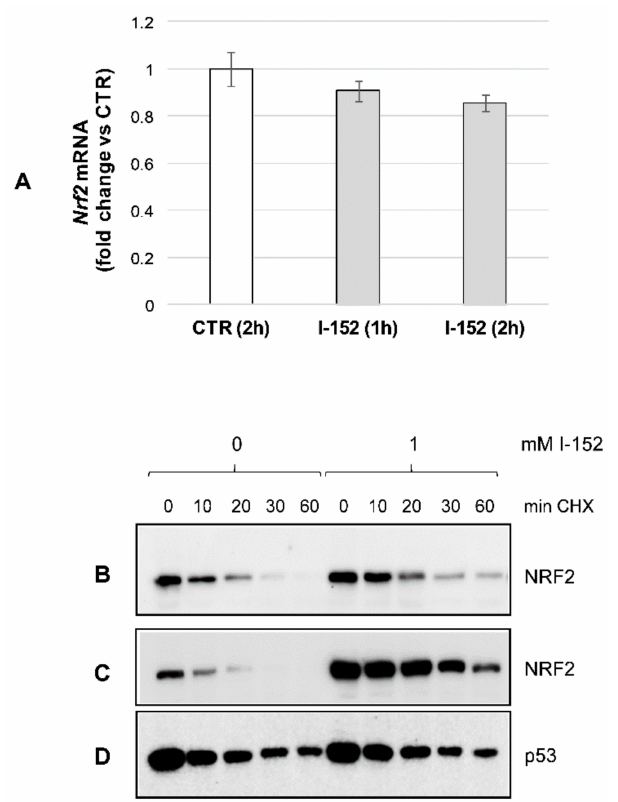
Figure 3. Nrf2 mRNA levels and NRF2 protein degradation after I-152 treatment. ( A ) RTqPCR analysis of Nrf2 mRNA levels in cells treated with 1 mM I-152 for 1 h and 2 h. Expression levels were normalized to the housekeeping genes Gapdh and Gusb and expressed as fold-change versus untreated cells (CTR). The values are the mean ± SD of two independent experiments with two technical replicates ( B ) Western immunoblotting analysis of NRF2 levels in extracts obtained from cells treated with 1 mM I-152 together with cycloheximide (CHX) for different times. Control cells were left untreated and incubated only with CHX (0). In some experiments, CHX was added after 30 min pre-incubation with I-152 and NRF2 ( C ) and p53 ( D ) protein levels were determined by western blotting. Ten µ g of total proteins were loaded on 8% ( w/v ) SDS polyacrylamide